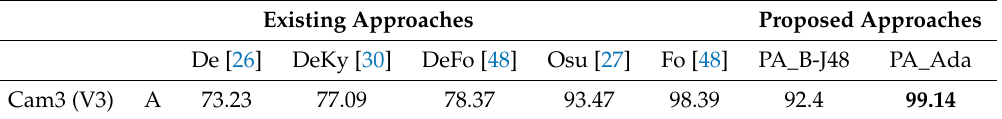
Figure 4. Experiment 1: A comparison of the existing approaches and the proposed approaches on the MCF dataset with 10-fold cross validation using two categories: ‘Fall’ and ‘No Fall’. ( a ) Graph; ( b ) ROC curve. Table 2. Experiment 1: Comparison of the existing approaches, De, DeKy, DeFo, Osu, Ky, and Fo, with the proposed approaches ‘PA_B-J48’ and ‘PA_Ada’ in terms of % accuracy (A) at camera position 3 of video 3 (V) of the MCF dataset with 10-fold cross validation using two categories: ‘Fall’ and ‘No Fall’. Maximum value in each row is shown in bold.